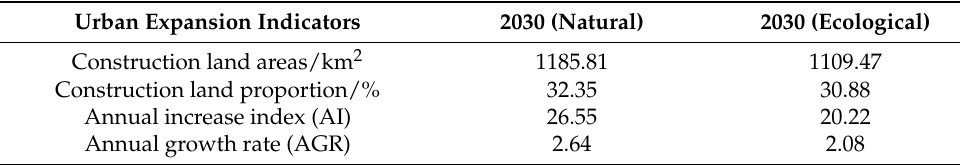
Table 5. Characteristics of urban expansion from the city center in